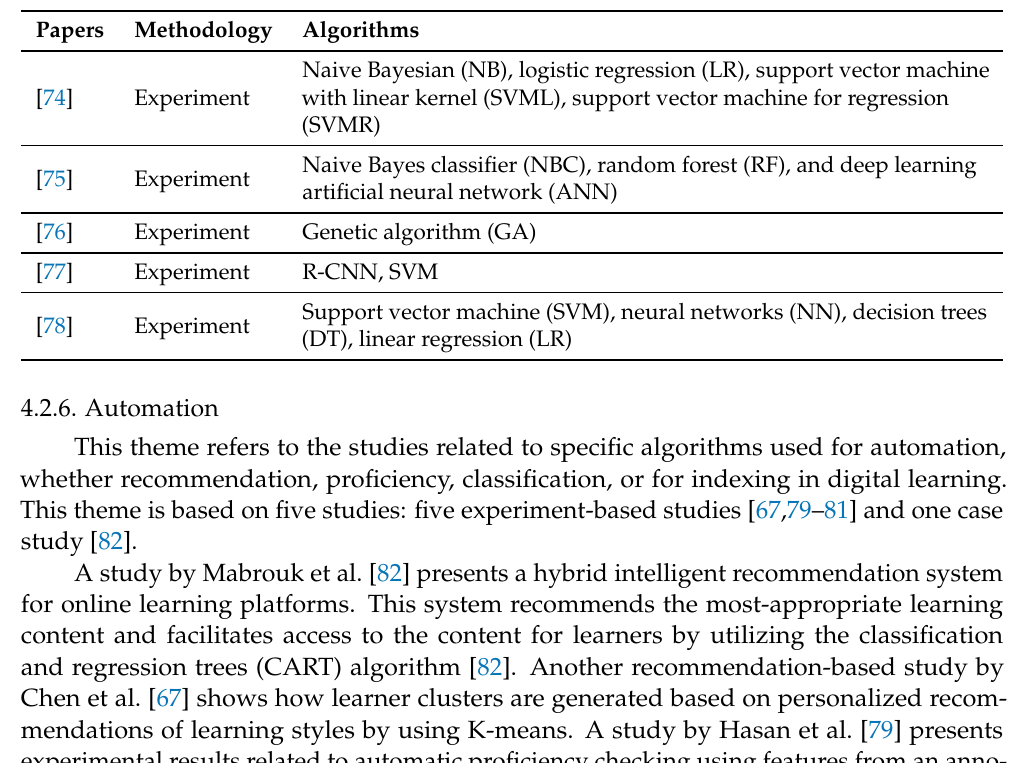
Table 6. Algorithms and approaches used for analytics, assessments, and group-based